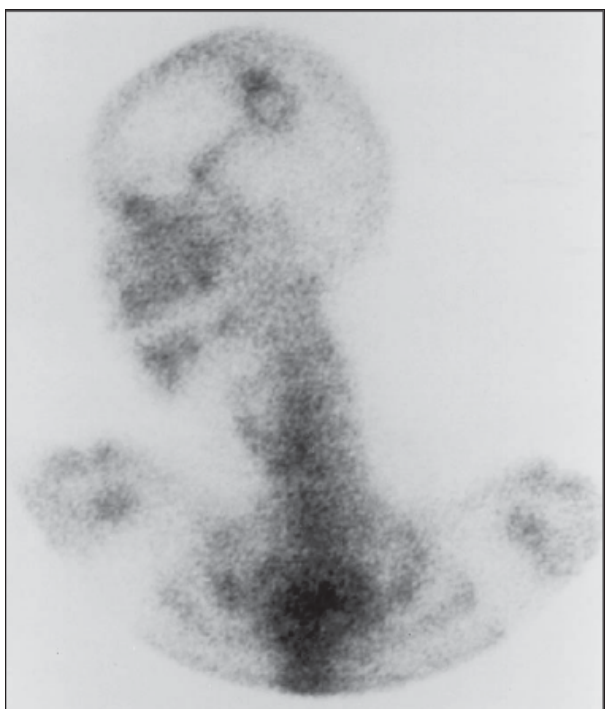
lytic lesion on plain skull film is shown